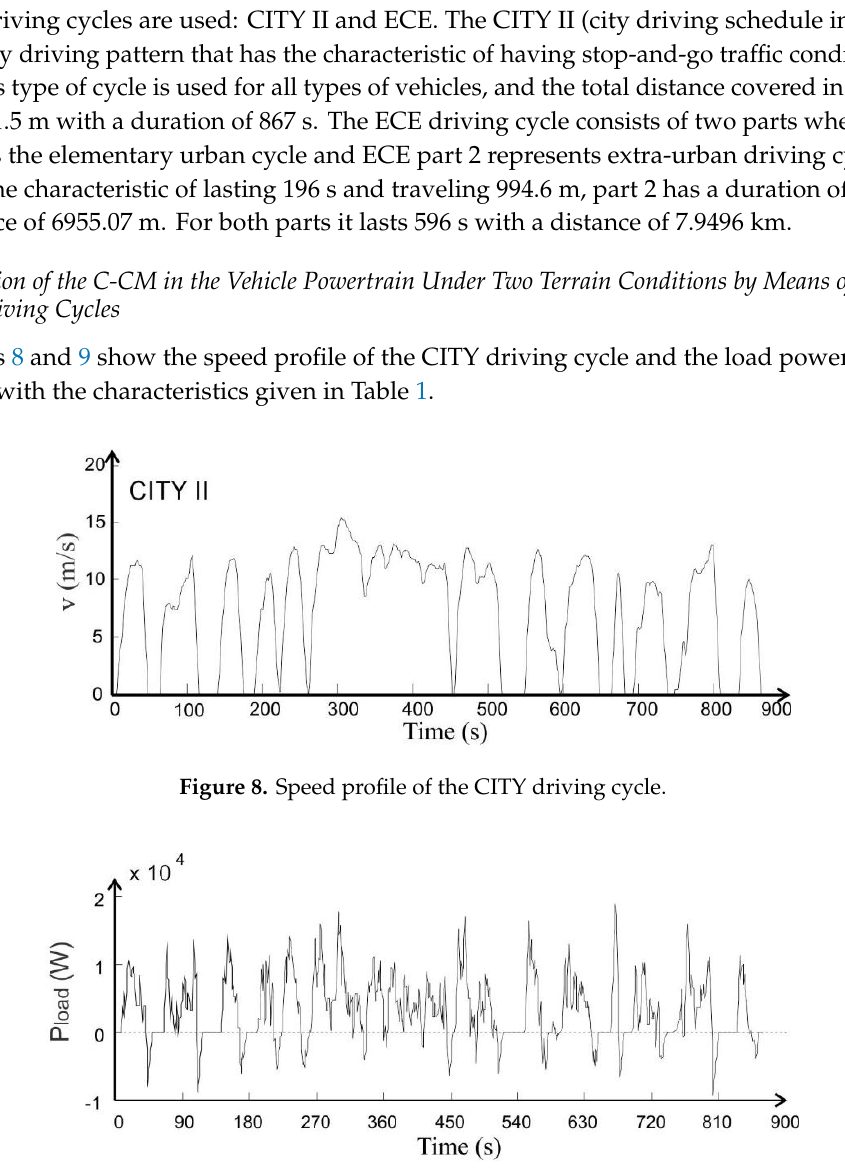
Figure 9. Vehicle load power profile.